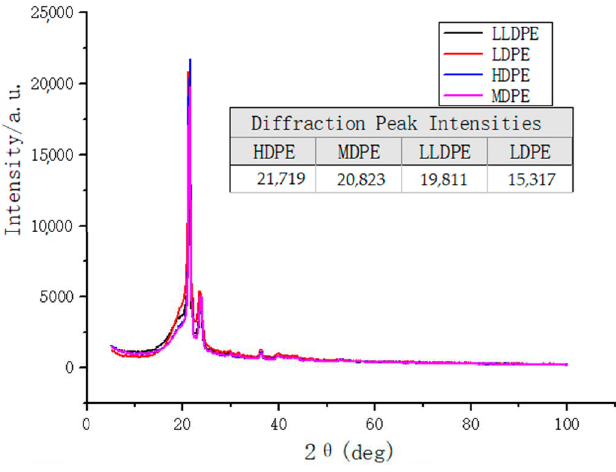
Figure 3. XRD images of four kinds of polyethylene.